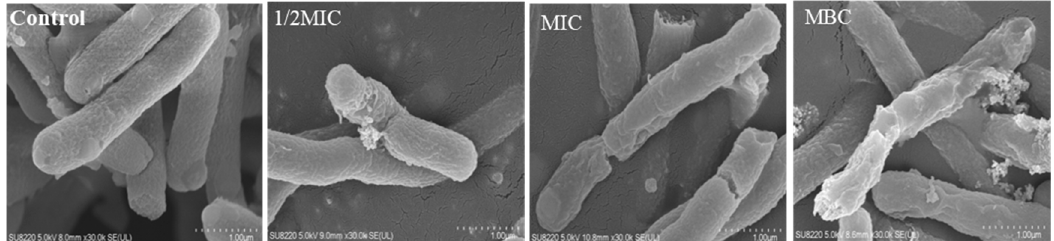
Figure 4. FE ‐ SEM images of P. aeruginosa following juglone treatment. Figure 4. FE-SEM images of P. aeruginosa following juglone